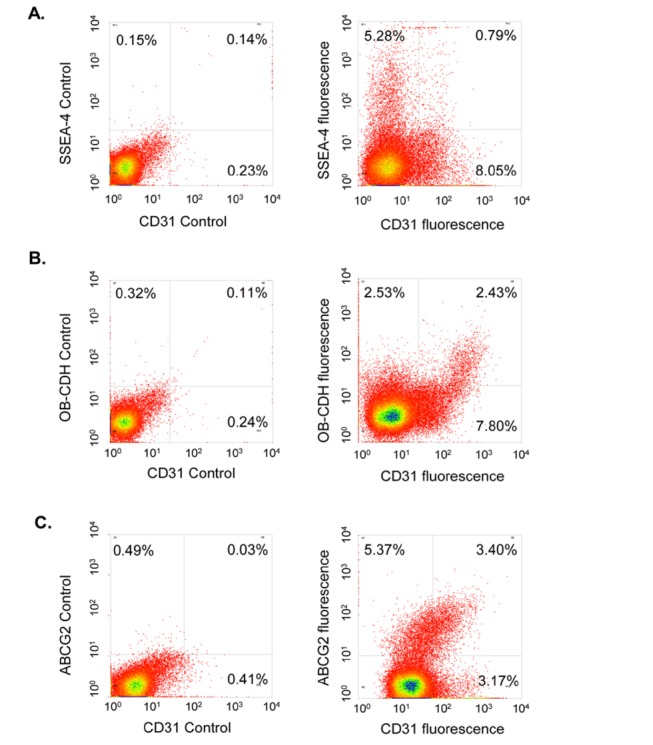
SSEA-4 staining does not overlap with CD31, whereas OB–CDH or ABCG2 staining partially overlaps with CD31.To examine the origin of these cell subpopulations, aortic pVICs were double stained with CD31 and one of the following markers: SSEA-4, OB–CDH or ABCG2. CD31 is expressed by porcine valvular endothelial cells but not by pVICs. From (A), SSEA4 and CD31 labeled distinct cell subpopulations. However, OB–CDH+ or ABCG2+ cells showed heterogeneous CD31 staining. About 52% of OB–CDH+ cells were CD31- and ~61% of ABCG2+ cells were CD31-, indicating that a majority of these cells are from pVICs rather than endothelium.